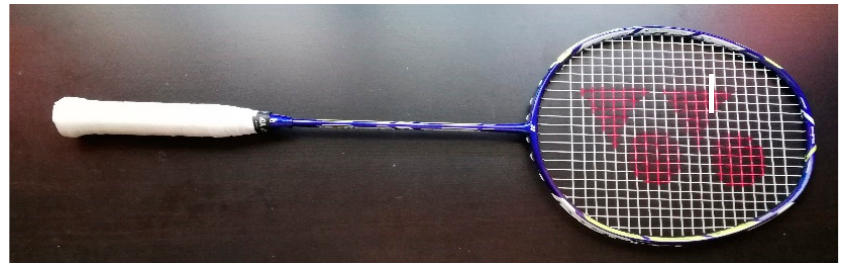
Figure 3. Yonex Duora 88. Length: 675 ± 3 m; width: 189 ± 3 mm. Each athlete performed at 10 valid BH smashes with each racket, according to the protocol presented in Table 1. Table 1. Protocol for the sEMG evaluation.